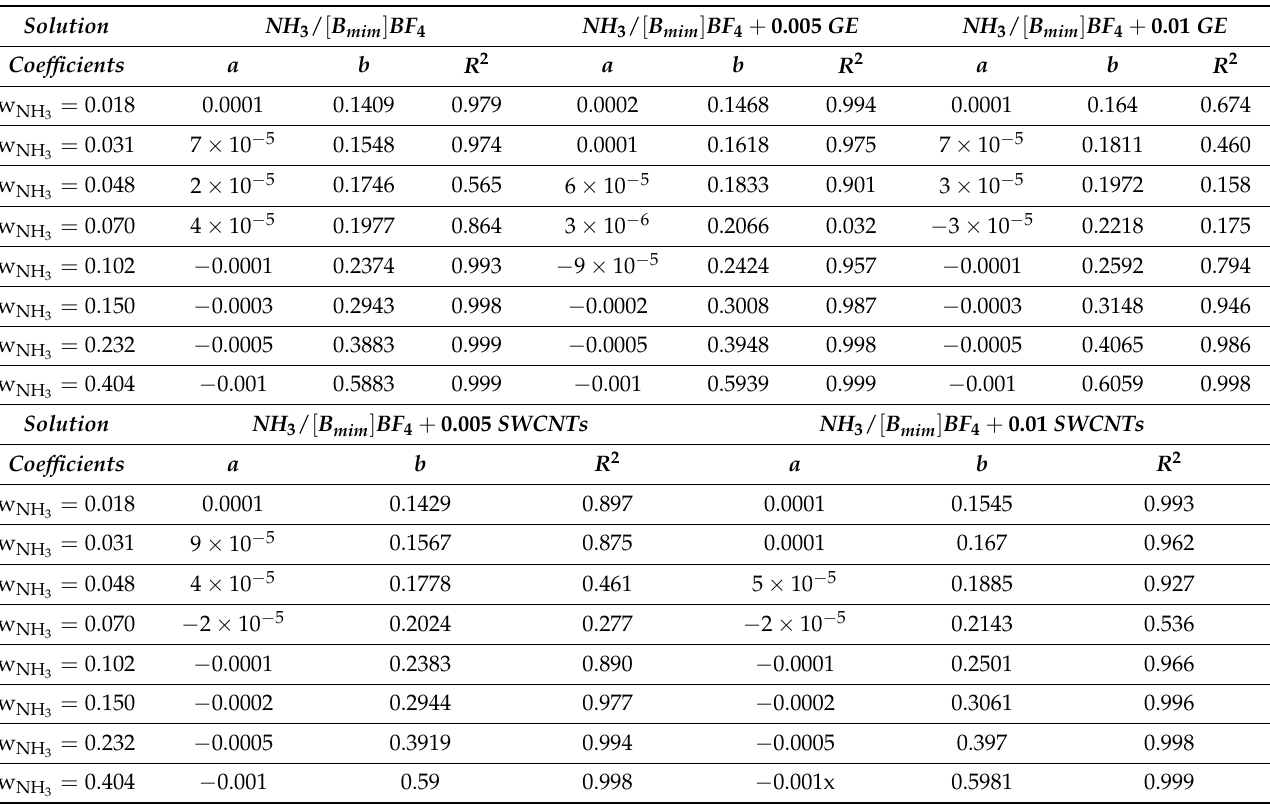
Table 3. Coefficient values a , b , and R 2 obtained by fitting Equation (4).